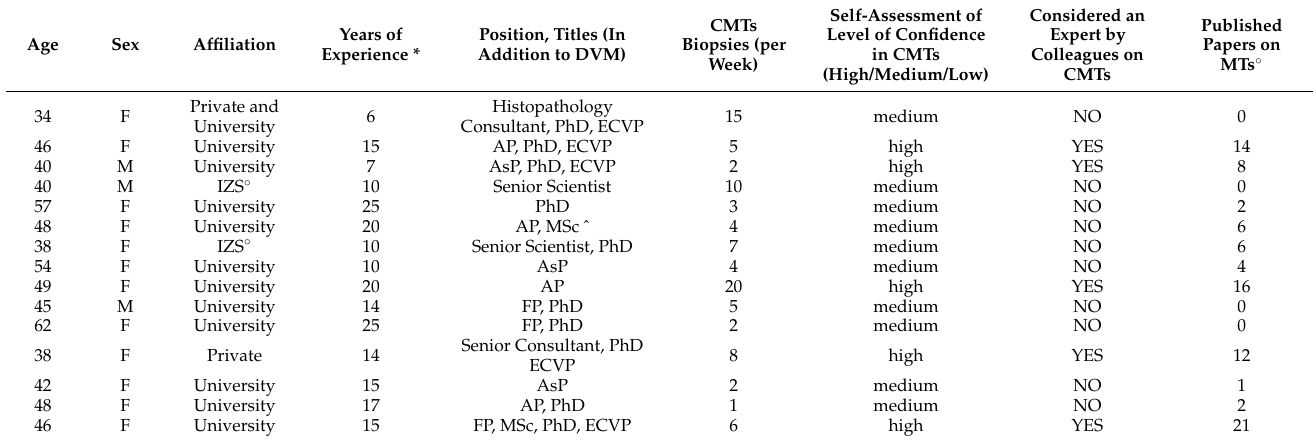
Table 4. Characteristics of working panellists at the time of the study.